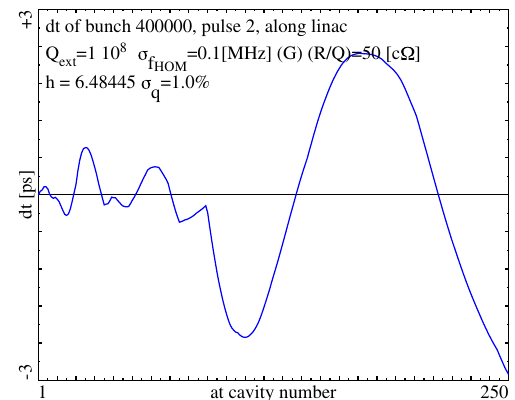
FIG. 60. (Color) As above but for pulse 2 (same data as in phase space of Fig. 8). The envelope increases with bunch number (time) but does not start with zero amplitude here since for ¼ 10 8 fields of the last pulse survive. Q ext